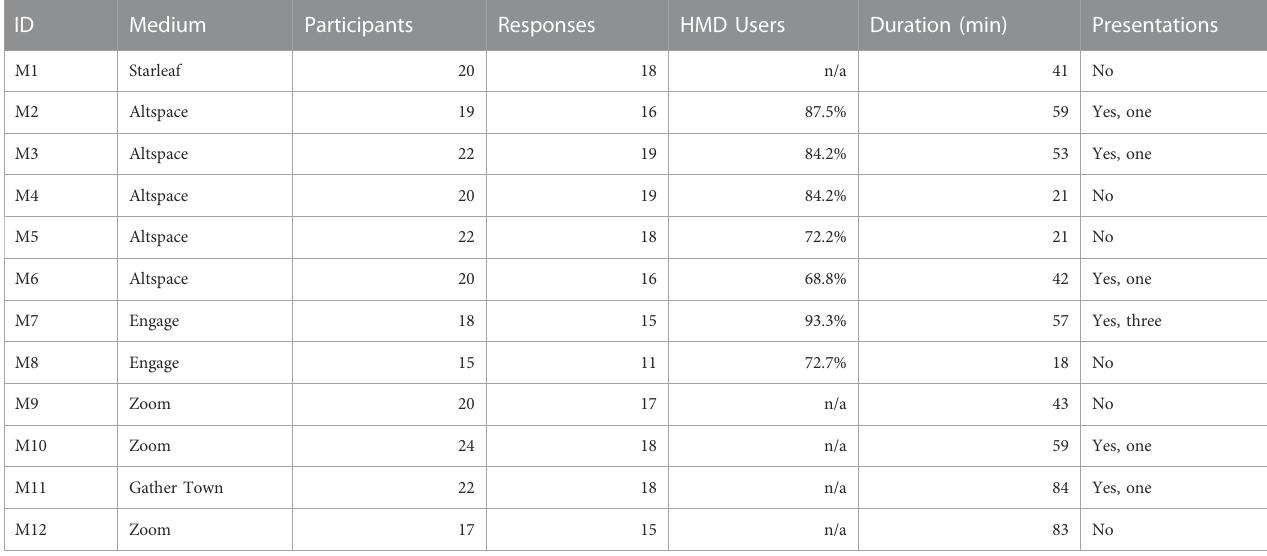
TABLE 1 Overview over the 12 evaluated